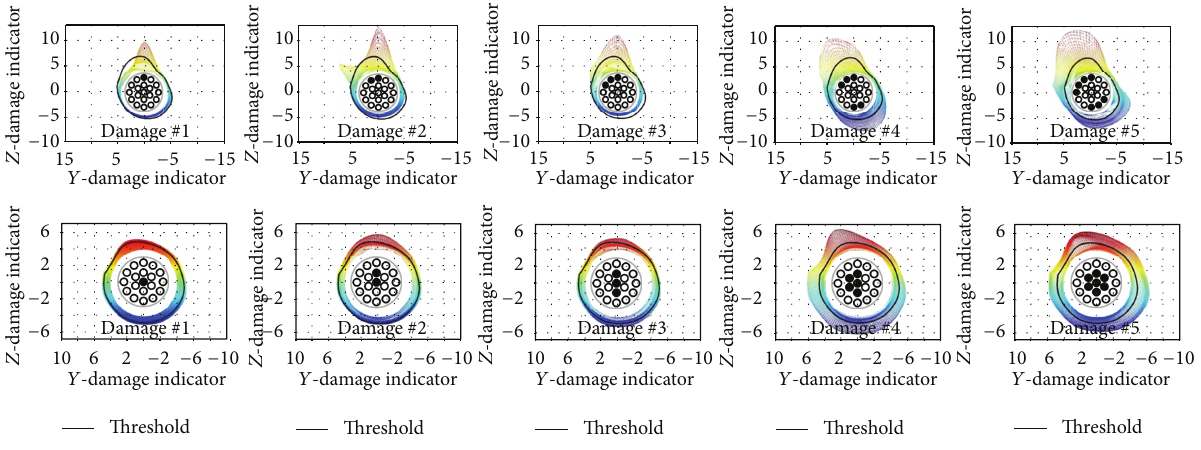
Figure 24: Visualized cross sections with threshold level.